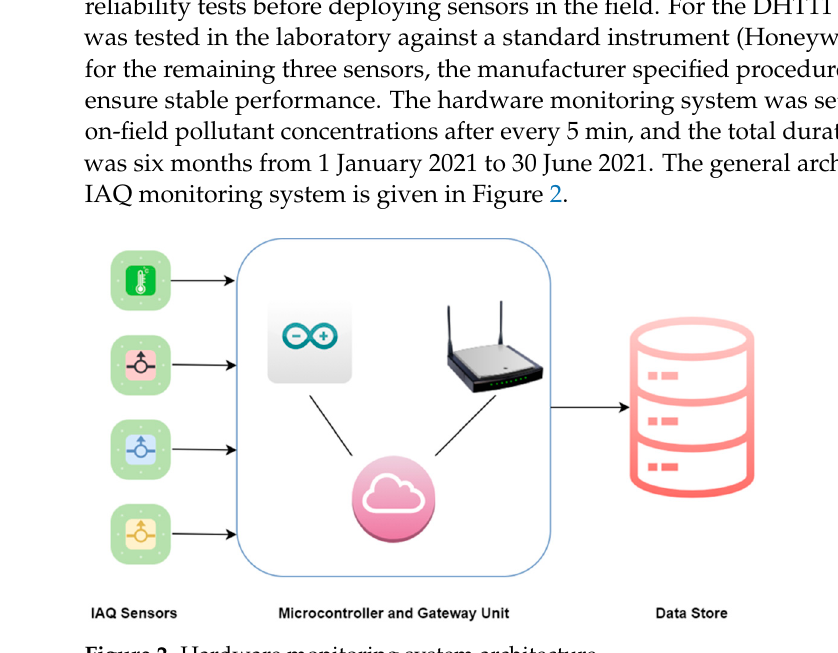
Figure 2. Hardware monitoring system architecture.